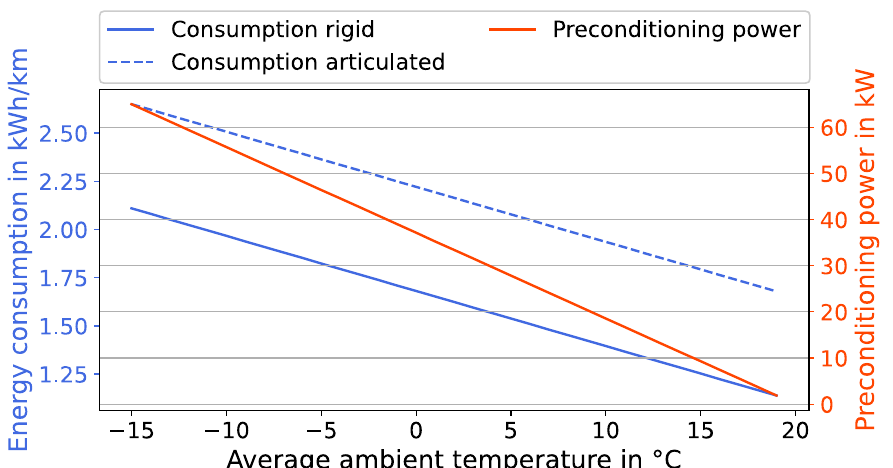
Figure 3. Average energy consumption of the buses and the preconditioning power dependent on the ambient temperature.